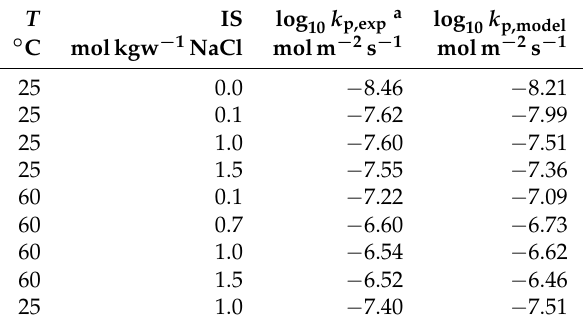
Table A1. Rate constants for bulk precipitation of barite at varying conditions used for the linear regression. The parameters T and IS are the input factors. Comparing experimental and model rates = 0.88. yields R 2 adj T IS log ◦ C molkgw − 1 NaCl molm − 2 s −